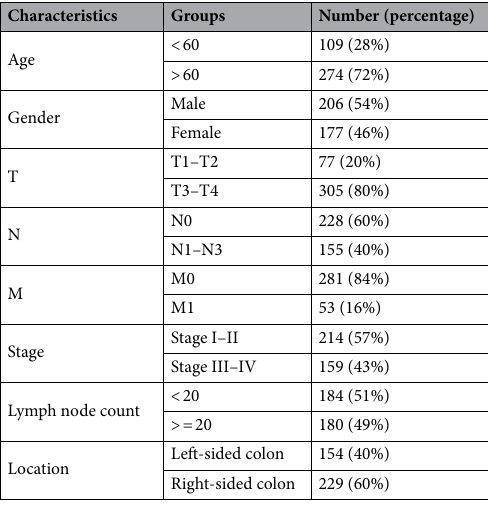
Table 1. Clinical characteristics of the colorectal cancer patients.